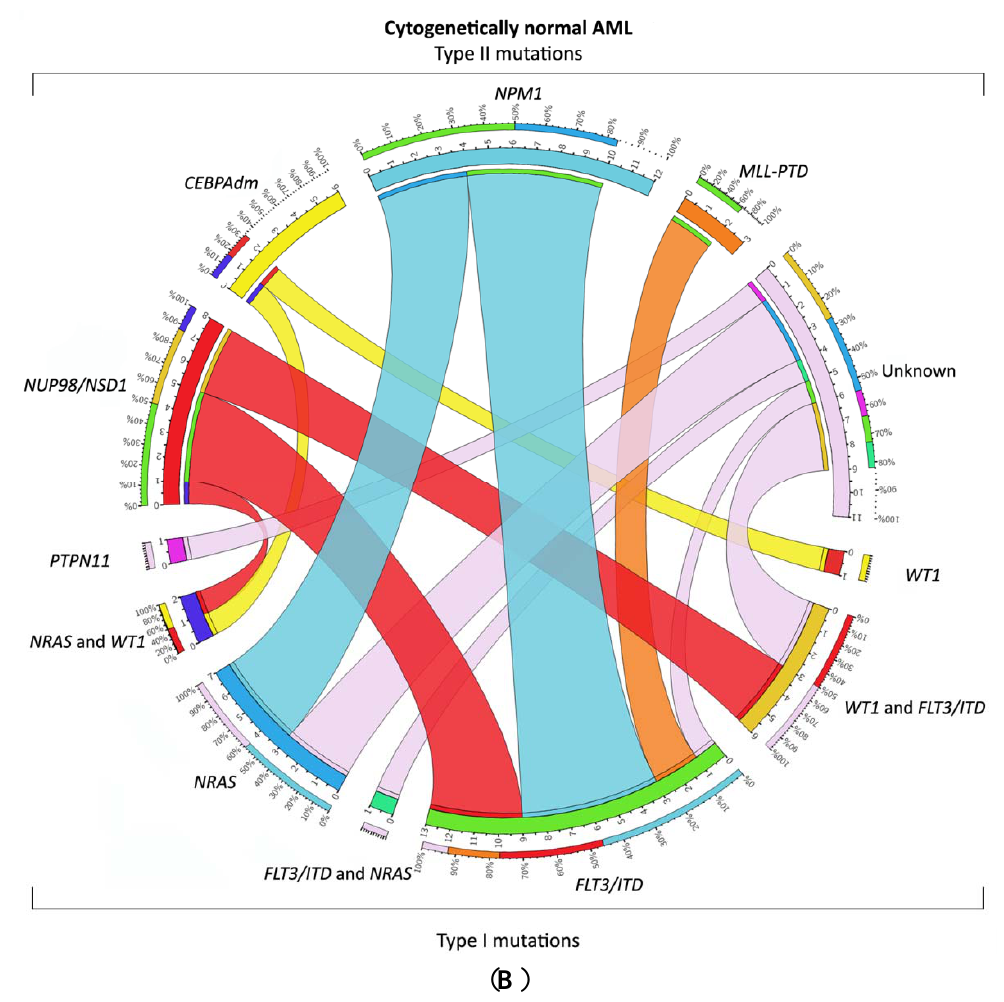
Figure 1. Distribution of Type I/II abnormalities in pediatric AML. ( A ) Cooperating Type I and Type II mutations in pediatric AML. The circos plot [73] depicts the frequency of the Type II mutations and co-occurrence of Type I mutations in patients with de novo pediatric AML. The length of the arch corresponds to the frequency of the Type II mutation and the width of the ribbon with the percentage of patients with a specific Type I mutation or a combination of Type I mutations. FLT3/ITD denotes FLT3 internal tandem duplication; ( B ) Cooperating Type I and Type II mutations in cytogenetically normal AML. The circos plot [73] depicts the frequency of the Type II mutations and co-occurrence of Type I mutations in patients with de novo pediatric cytogenetically normal AML. The length of the arch corresponds to the frequency of the Type II mutation, and the width of the ribbon with the percentage of patients with a specific Type I mutation or a combination of Type I mutations. FLT3/ITD denotes FLT3 internal tandem